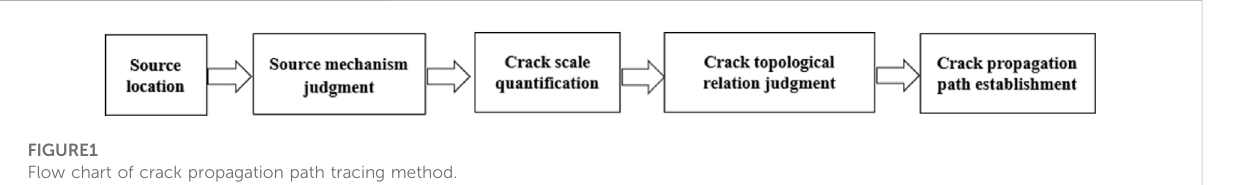
FIGURE1 Flow chart of crack propagation path tracing